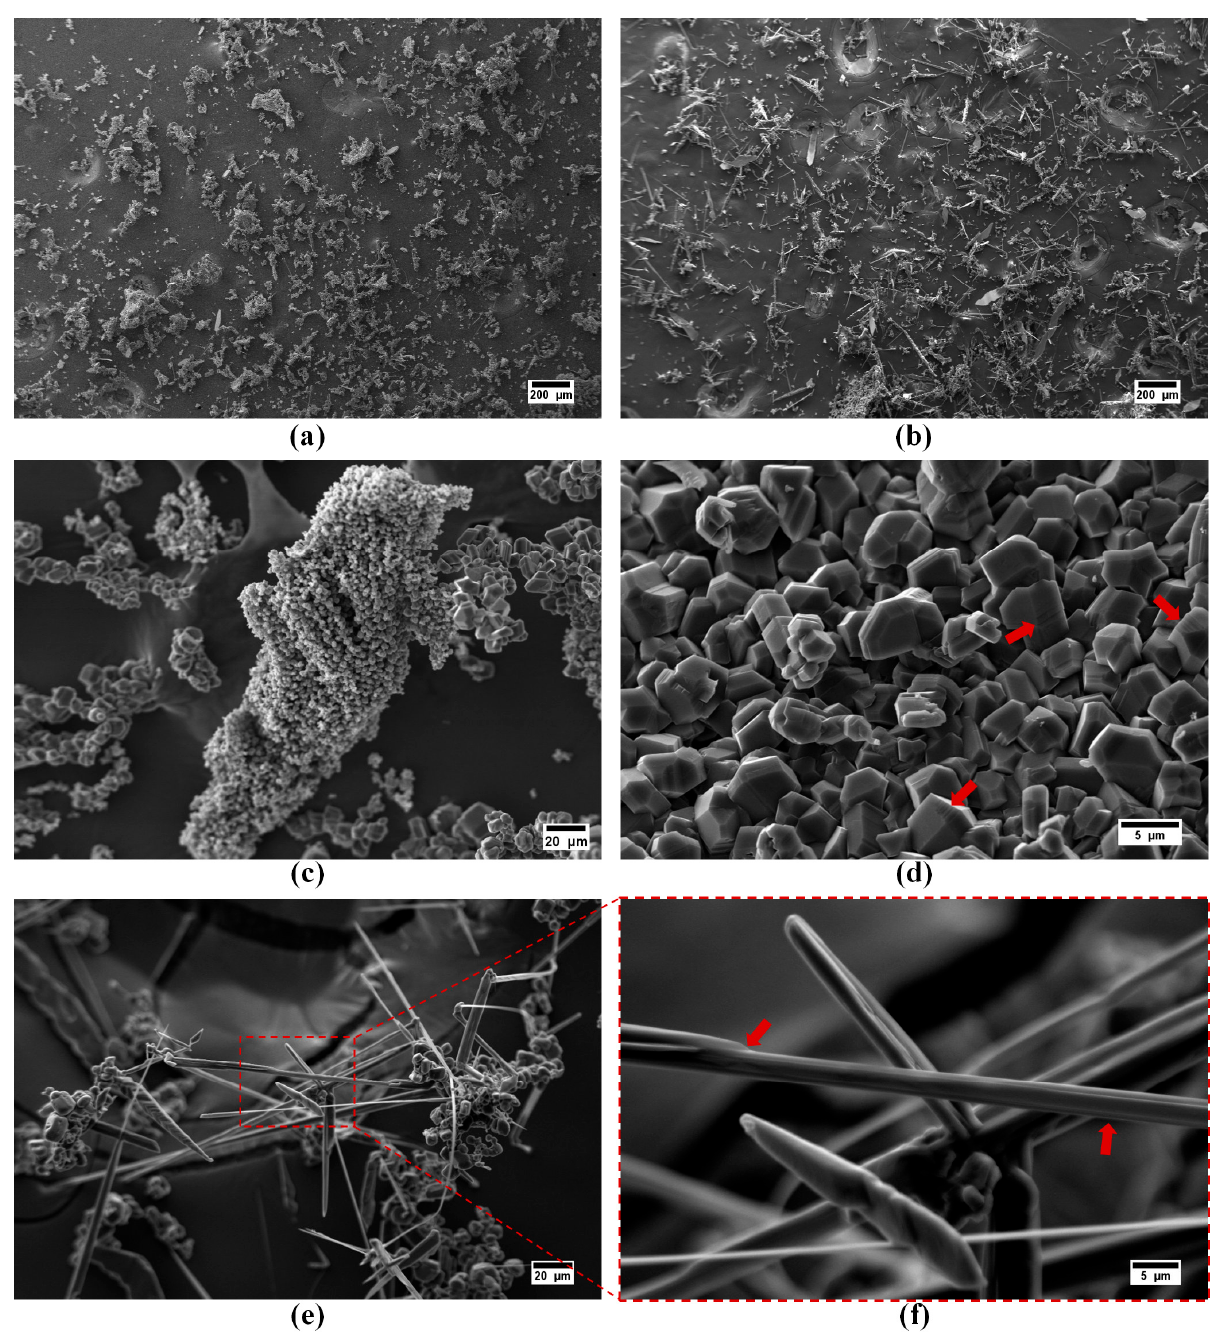
Figure 4. SEM images of the boron carbide as-synthesized powders derived from ( a , c , d ) 1Y and ( b , e , f ) 2Y precursors. The surface features of particles are emphasized with arrows.